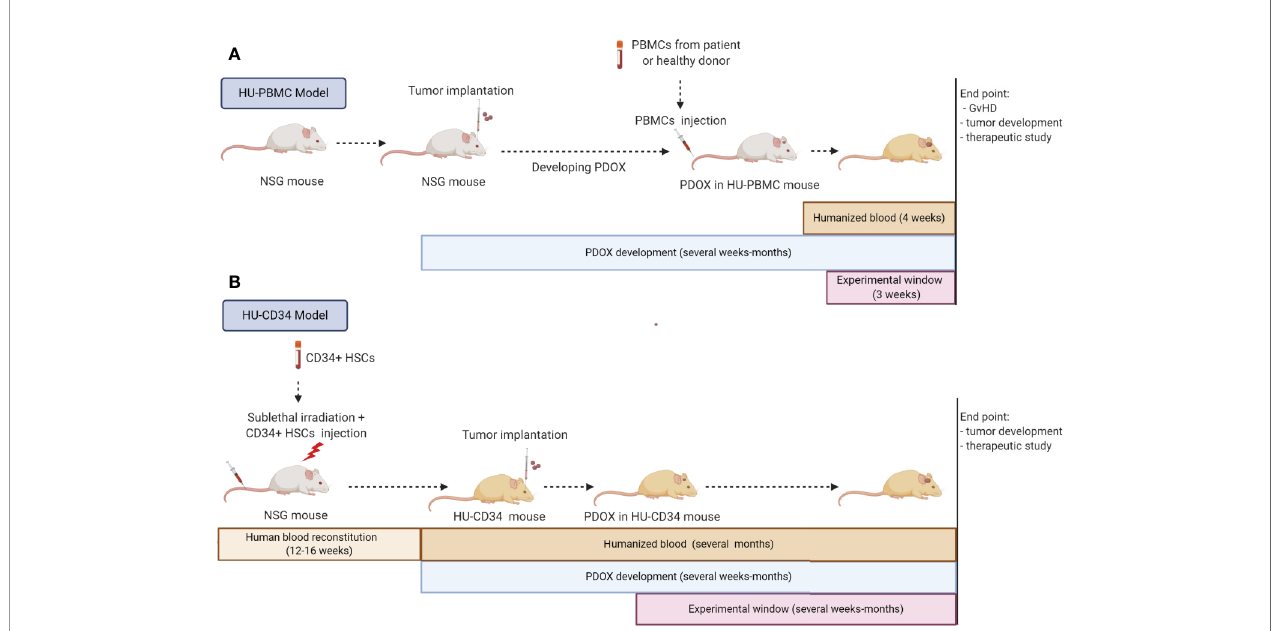
FIGURE 3 | Strategies for immunocompetent GBM PDOXs development in humanized mice. Immunocompetent GBM PDOXs can be generated in HU-PBMC or HU-CD34 mice. The experimental schedule and therapeutic window depends on the humanized model applied and tumor development time (A) . Due to the short survival of HU-PBMC mice, tumor implantation should precede the PBMC injection. The best time point will depend on tumor latency. The experimental window is limited due to development of Graft versus Host Disease (GvHD) within 4 weeks, depending on the genetic background of the NSG mice (B) . HU-CD34 model requires more time for the generation of humanized blood which is counterbalanced by the longer survival of the mice (>1 year). The tumor implantation timepoint and experimental window depend on the tumor latency and need to be synchronized according to the required readout. Illustration created with